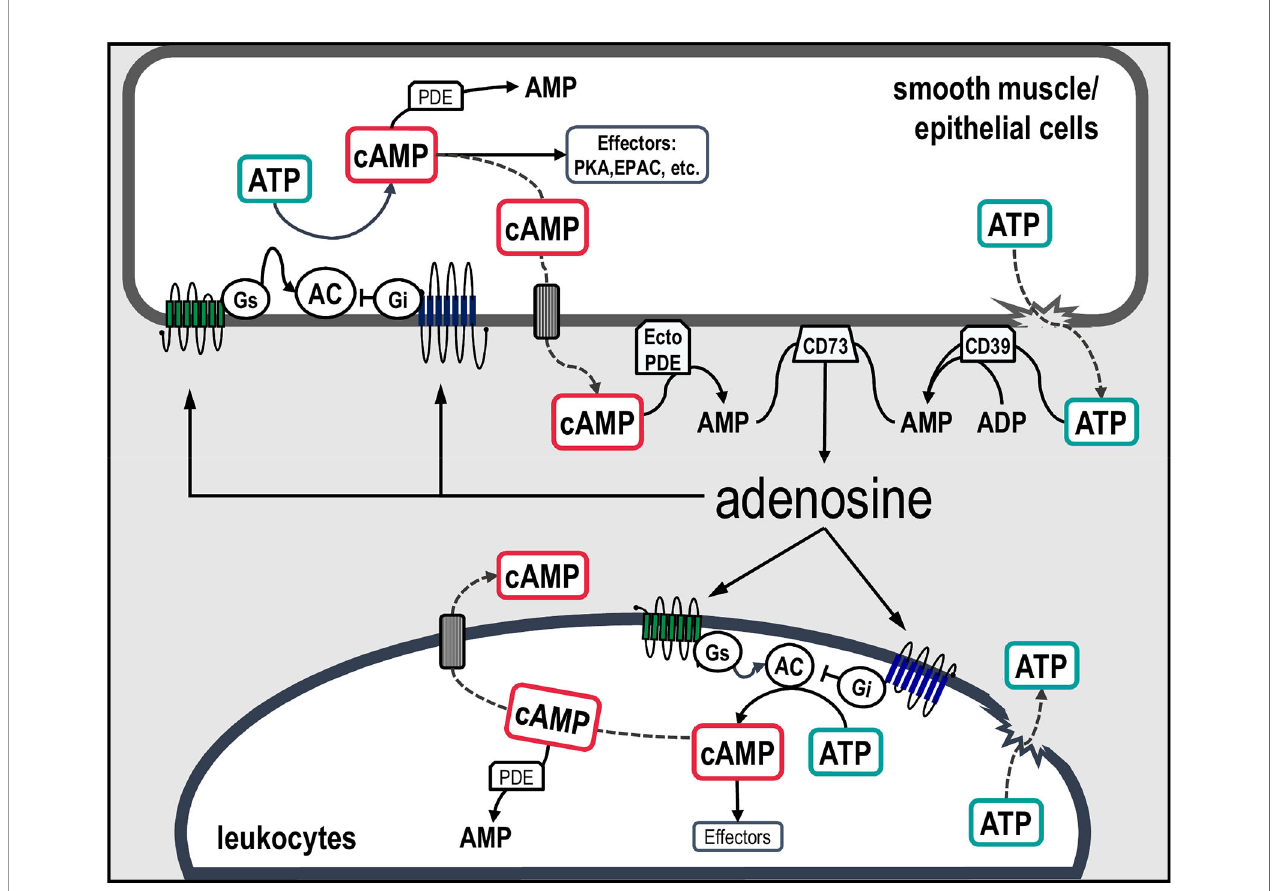
FIGURE 1 | Schematic representation of canonical and non-canonical pathways involved in extracellular adenosine formation in airway cells. Classically, extracellular adenosine is generated mainly via the dephosphorylation of ATP, ADP and AMP by the action of a series of ecto-enzymes. An alternative source of adenosine is the second messenger cAMP. In this scenario, intracellular cAMP synthetized by adenylyl cyclases can be transported to the extracellular compartment and sequentially metabolized into AMP and adenosine by ecto-PDE and CD73, respectively. Increased concentrations of adenosine activate adenosine receptors coupled to Gs or Gi proteins, which in turn regulates the activity of adenylyl cyclases leading to an increase or decrease in cAMP concentrations and stimulation of downstream effectors. AC, adenylyl cyclases; Gs, stimulatory G protein; Gi, inhibitory G protein; PDE, phosphodiesterase; PKA, cAMP-dependent protein kinase; EPAC, exchange protein directly activated by cAMP; CD39, NTPDase-1; CD73, ecto-5 ’ -nucleotidases and Ecto-PDE,